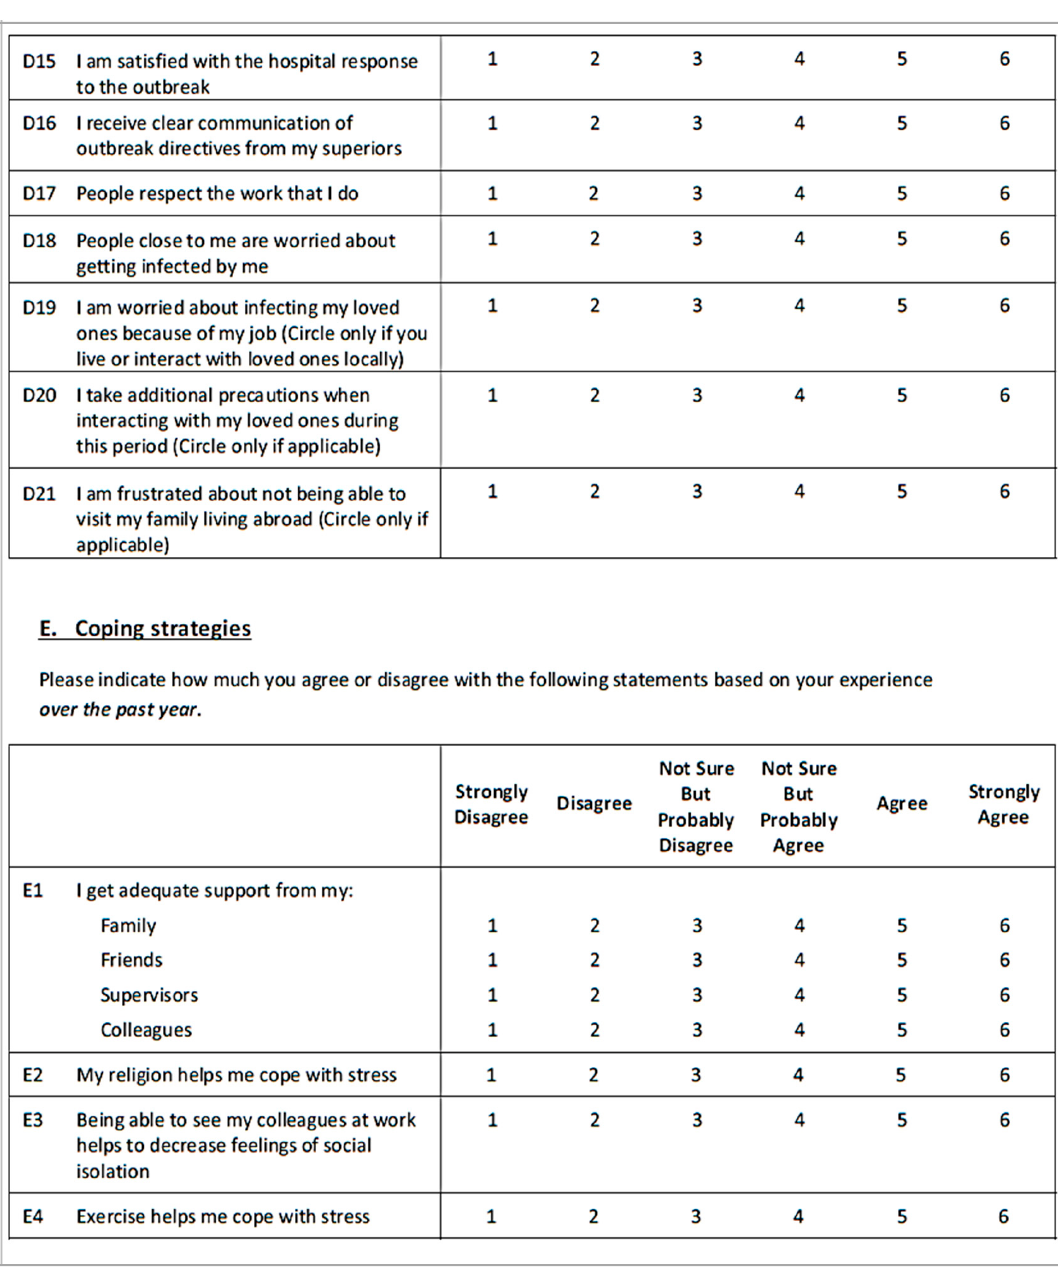
Figure A1. COVID-19 survey questionnaire for 2021.